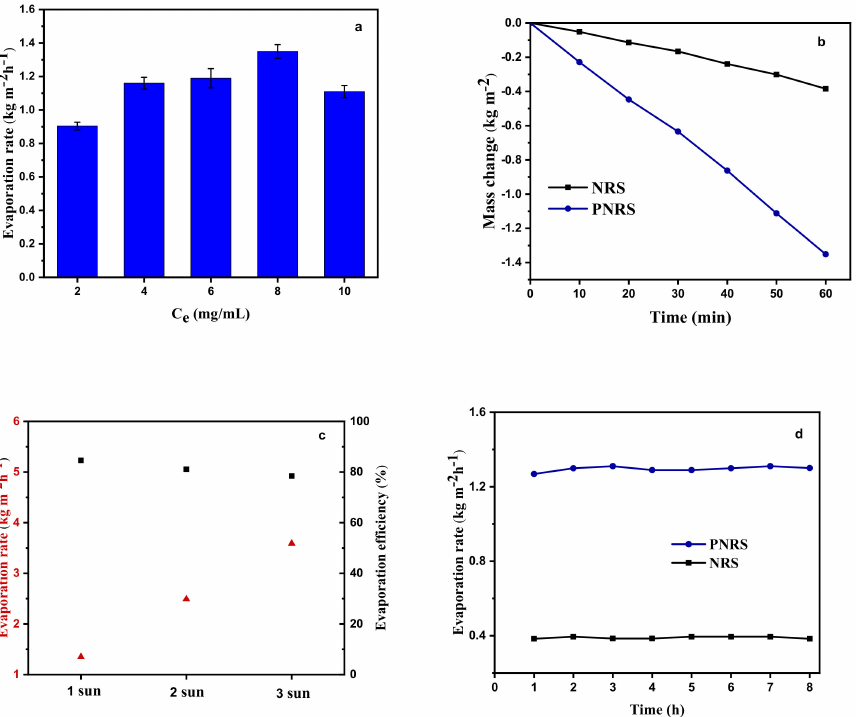
Figure 7. ( a ) Evaporation rate of PNRS modified with different concentrations of dopamine (1 sun); ( b ) water evaporation mass loss (1 sun); ( c ) evaporation rate and efficiency under different light intensities; ( d ) evaporation rate of PNRS with continuous desalination for 8 h (1